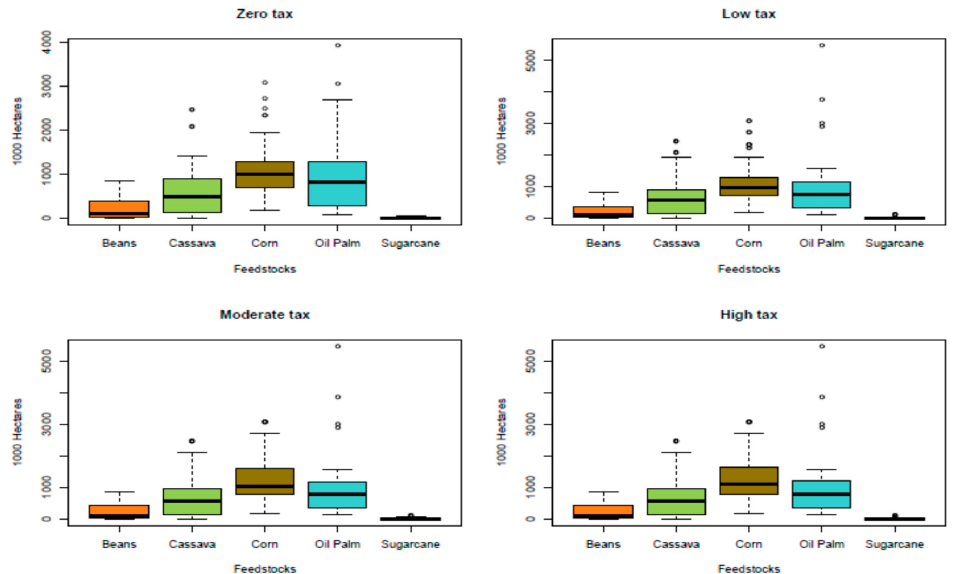
Figure 3. Bioenergy feedstock area by 2050 under no subsidy action.